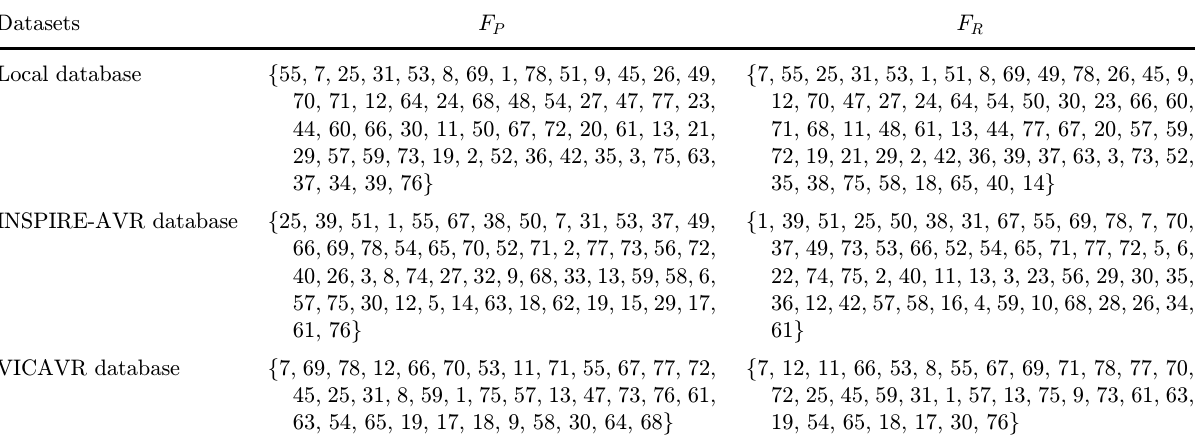
Table 4. Optimal feature sets obtained via fusion of features using PCC ( F P ) and Relief-F ( F R ) ranking.